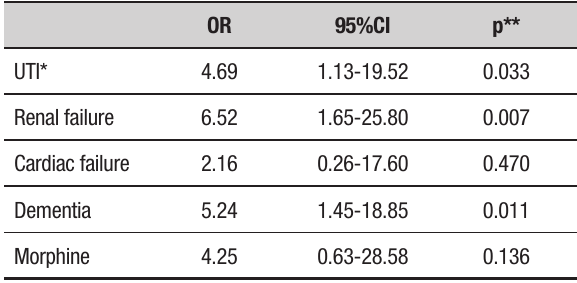
Table 3. Multivariate analysis with clinical conditions and